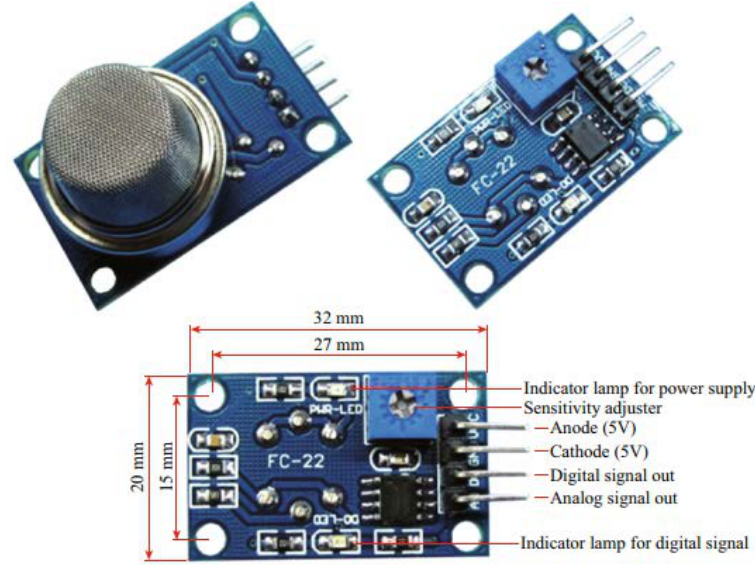
Figure 6. SnO 2 gas sensor for detecting CO; model: MQ-9.